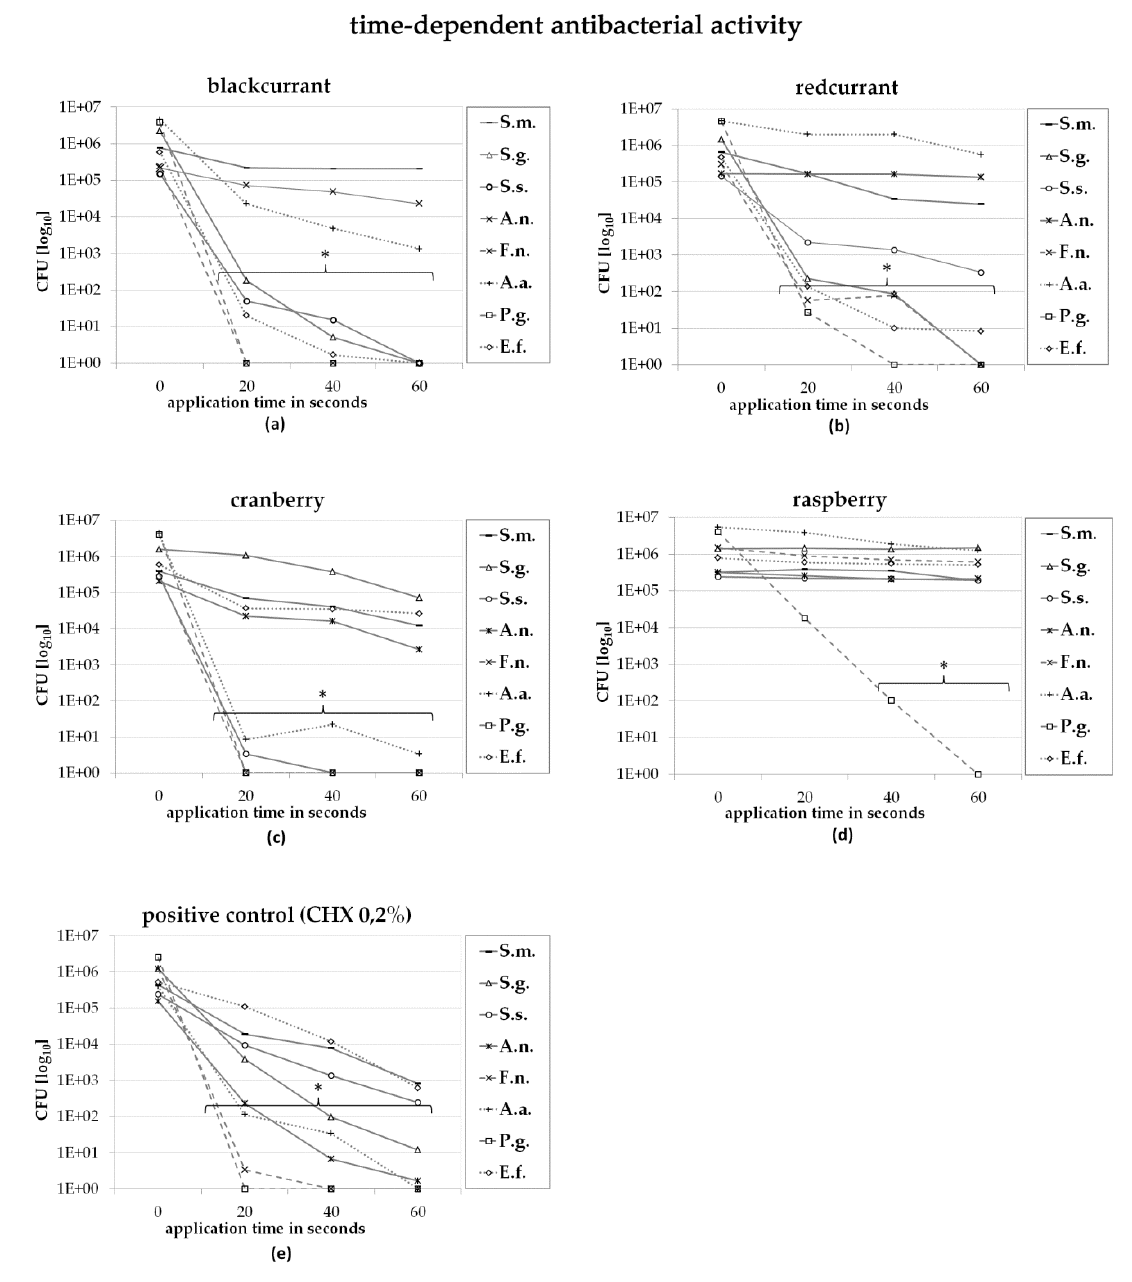
Figure 3. Direct contact test, time-dependence (incubation time 20 s, 40 s, 60 s; juice concentration 90%); * asterisked values show significant difference from the negative control. ( Streptococcus mutans -